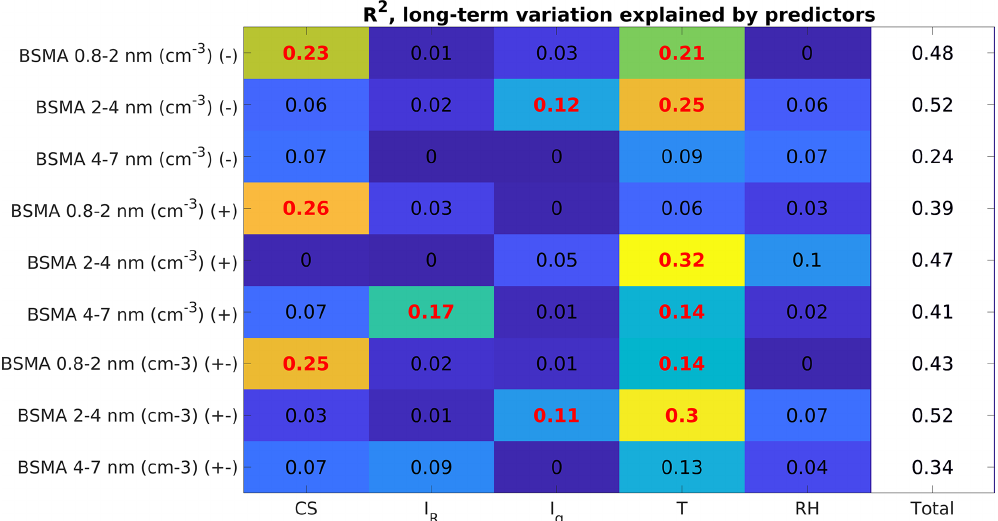
Figure 8. The amount of variation explained by our chosen explanatory variables for each size range and polarity for BSMA. The symbol ( − ) denotes negative polarity, ( + ) a positive polarity, and ( ± ) the sum of both polarities. The bolded red values are statistically significant ( p < 0 .